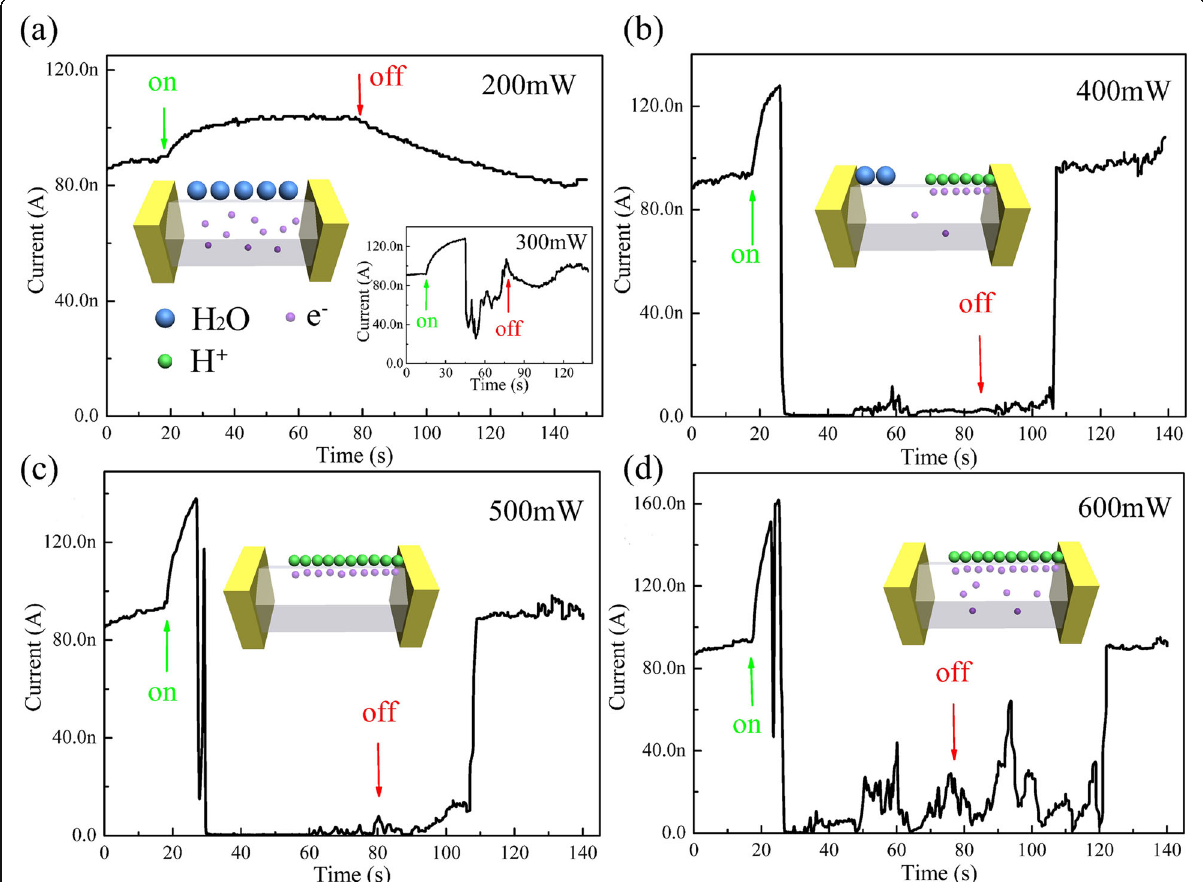
Fig. 3 Typical I-T curves ( V ds = 3 V) of an Au/h-WO 3 NW/Au device recorded repeatedly with laser (445 nm, 200 mW ( a ), 400 mW ( b ), 500 mW ( c ), and 600 mW( d )) on and off at 70% RH. The right inset of a : the I-T curves of 300 mW. The four schematic insets showing the effect of H + ions under different laser